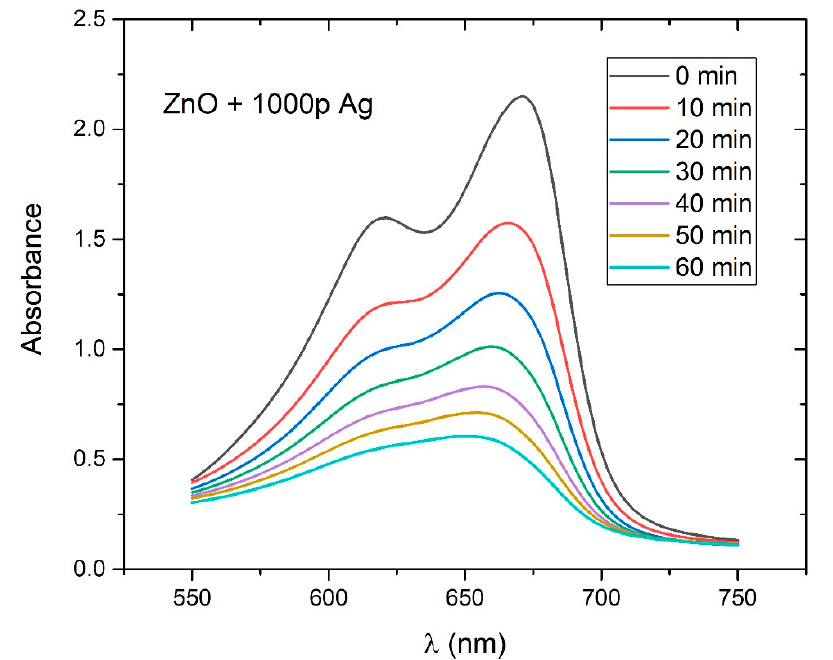
Figure 11. Photocatalytic degradation of MB in PLAL-synthesized colloidal solution of Ag-doped ZnO NPs (1000p used for Ag deposition in PLD) under UV irradiation .